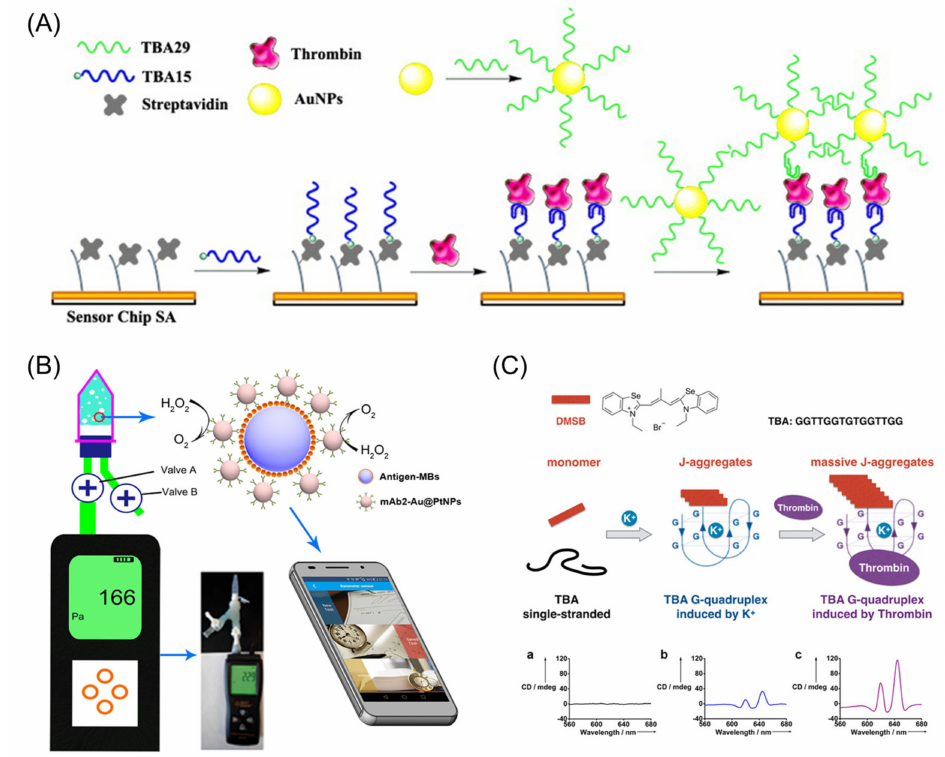
Figure 10. Scheme of some novel biosensors for detecting thrombin. ( A ) Schematic representation of AuNPs enhanced SPR aptamer sensor. Adapted with permission from Ref. [101]. Copyright (2013), Elsevier. ( B ) The portable barometer-based biosensor. Adapted with permission from Ref. [102]. Copyright (2017), American Chemical Society. ( C ) The assembly process of supermolecule and CD spectra of different aggregation states. Adapted with permission from Ref. [103]. Copyright (2017), American Chemical